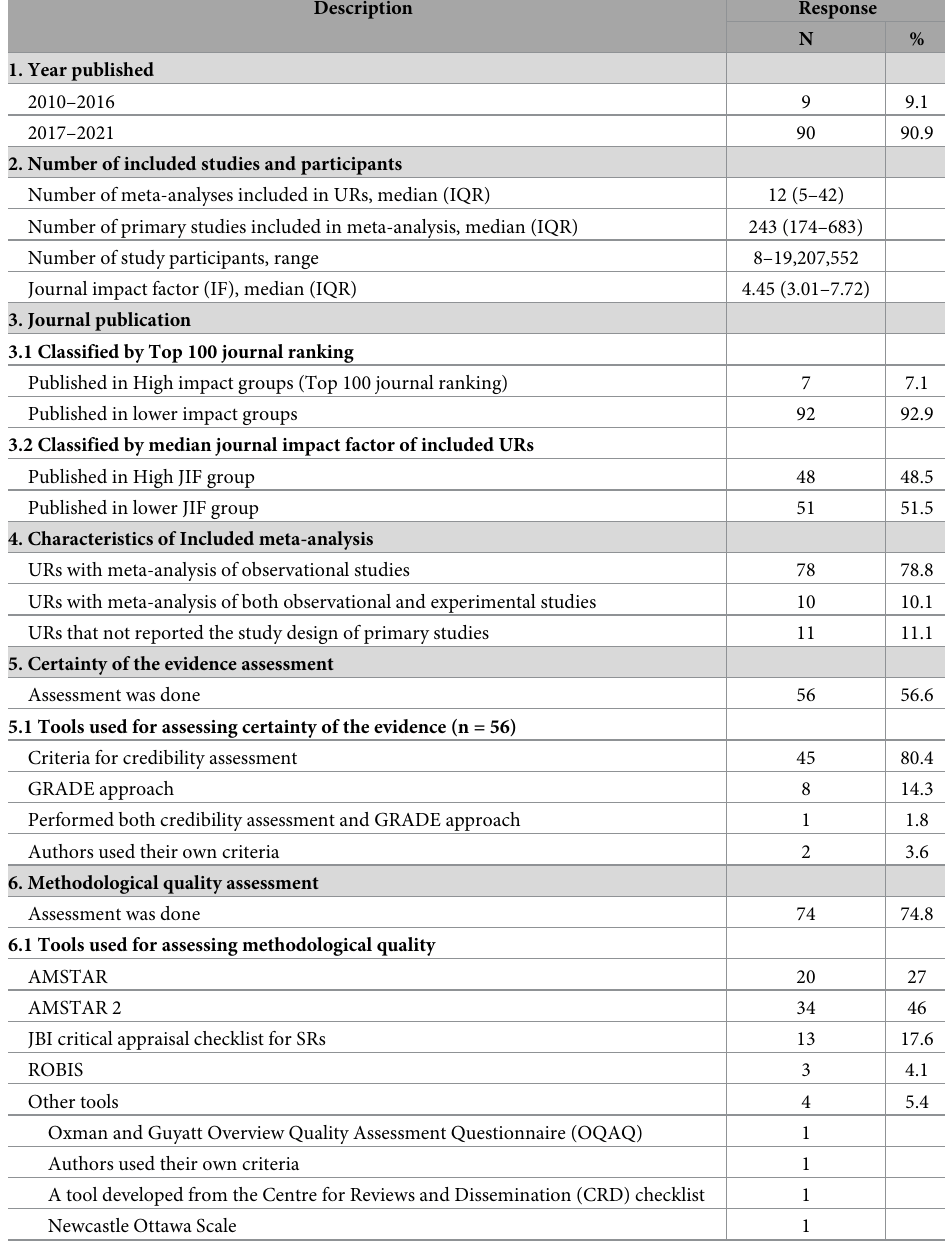
Table 1. Description of included umbrella